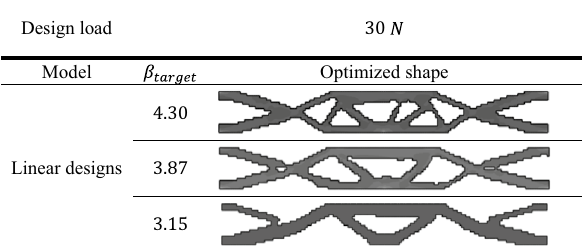
Table 3. The optimal solution of probabilistic linear design of the model.